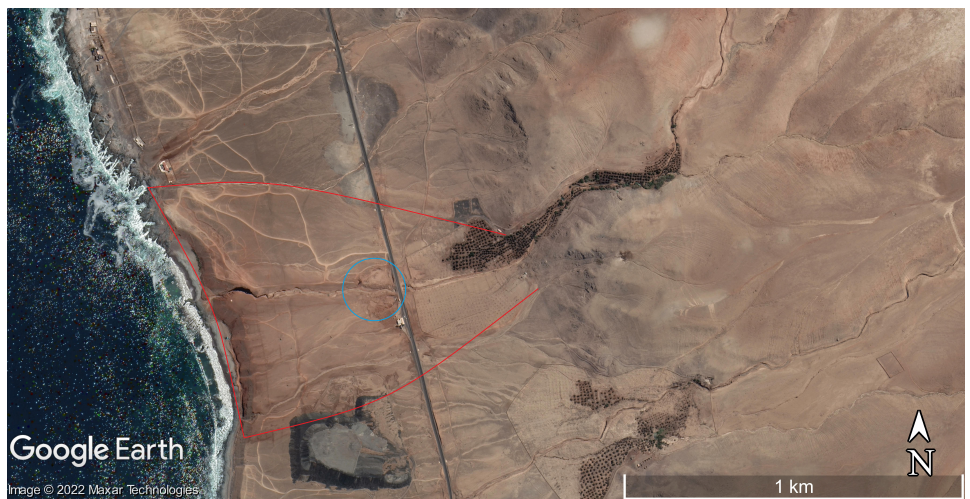
Figure 7. Quebrada Miraflores; 2021 satellite image (17 ◦ 25 (cid:48) 49 (cid:48)(cid:48) –17 ◦ 26 (cid:48) 36 (cid:48)(cid:48) S, 71 ◦ 22 (cid:48) 22 (cid:48)(cid:48) –71 ◦ 21 (cid:48) 42 (cid:48)(cid:48) W). The extent of the Miraflores Unit according to Satterlee et al. [22] is marked by a red line and the location of Chiribaya settlement by a blue circle (see text).